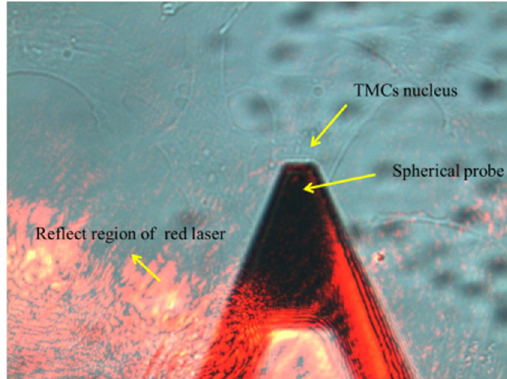
Figure 1. Mechanical testing of TM cells by AFM.